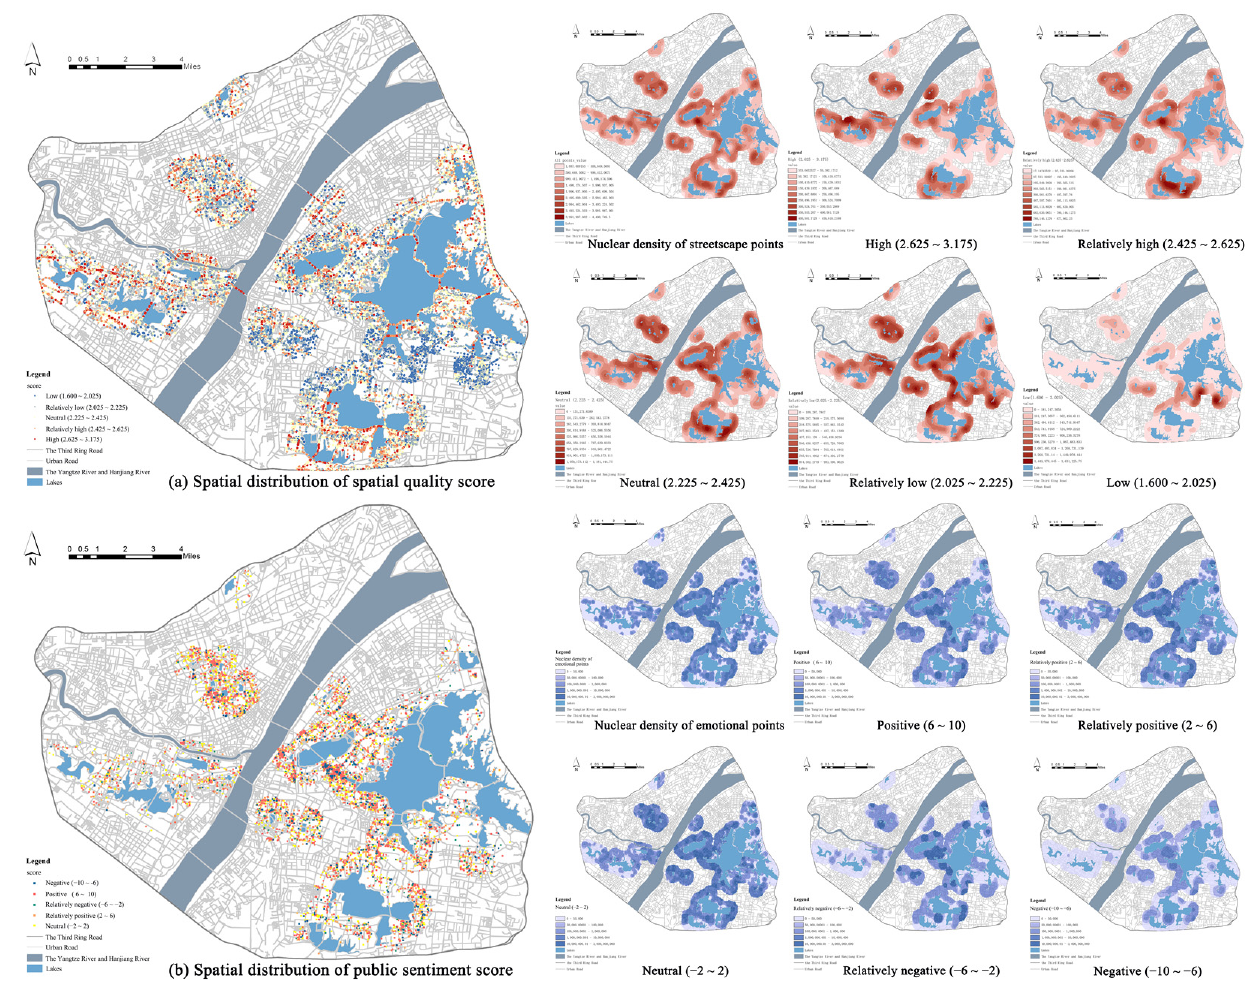
Figure 8. Spatial distribution of spatial quality and public sentiment (see Figure A1 in Appendix A). In the spatial dimension, the hot and cold spots of spatial quality are distributed in a contiguous pattern, whereas the hot and cold spots of public sentiment are distributed in multiple clusters (Figure 9). In particular, the hot spots of spatial quality are mainly distributed in the buffer zone between the north and south of Hanyang District, Wuchang District, and the east and west of Hankou District, whereas the cold spots are concentrated in the lakefront area in the middle of Wuchang District. By contrast, no similar distribution of public sentiment exists. Its hot spots are scattered in the lakefront area of Simei Pond-Sha Lake in Wuchang District, the southeast side of the lakefront area of South Lake, and the central part of the lakefront area of the series of lakes in Hankou District, whereas the cold spots are mainly distributed in the periphery of the lakefront area of East Lake, Ziyang Lake–Shai Lake in Wuchang District, and the series of lakes in Hankou